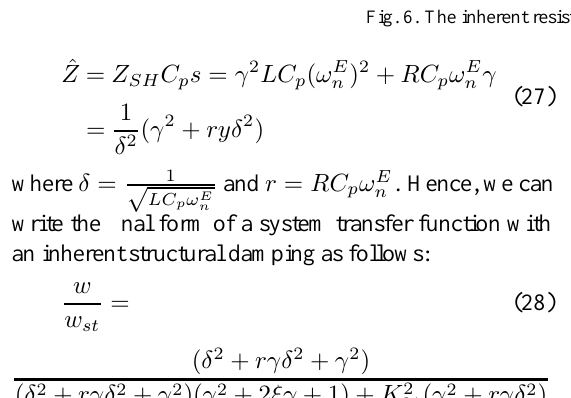
Fig. 6. The inherent resistances of a synthetic